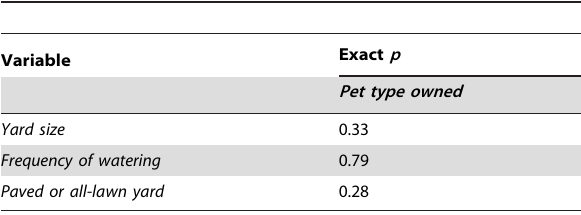
Table 2. Yard size, paving and watering frequency were not related to the type of pet